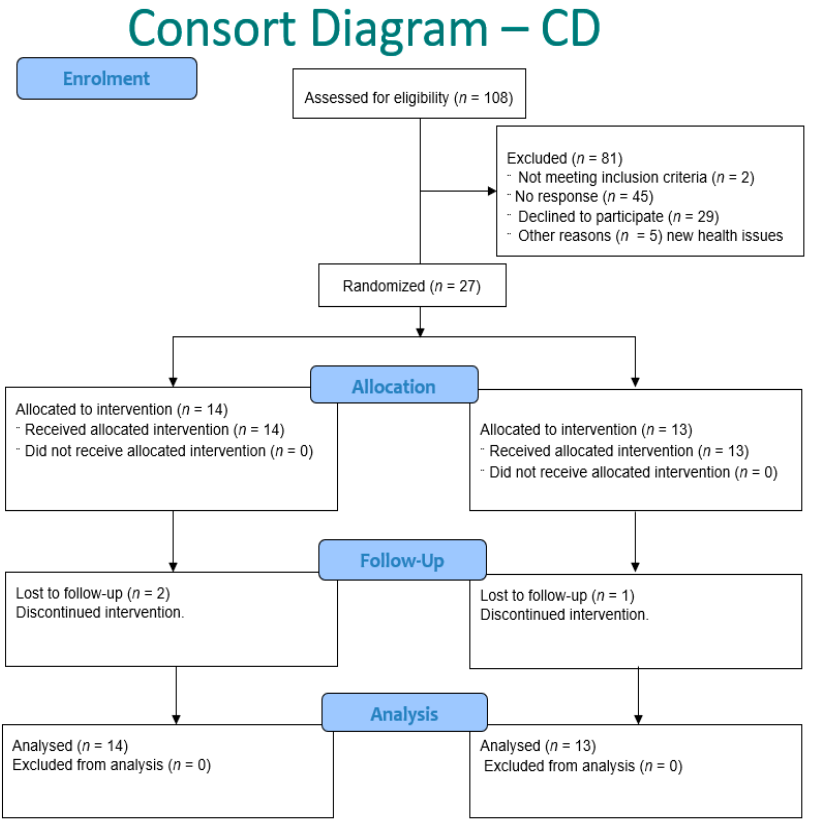
Figure 3. Consort diagram for trial for CD participants.